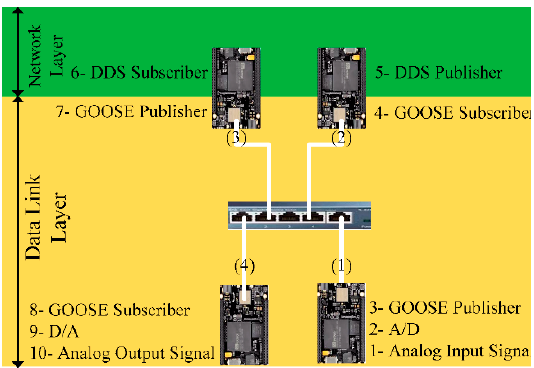
Figure 3. The test framework configuration.